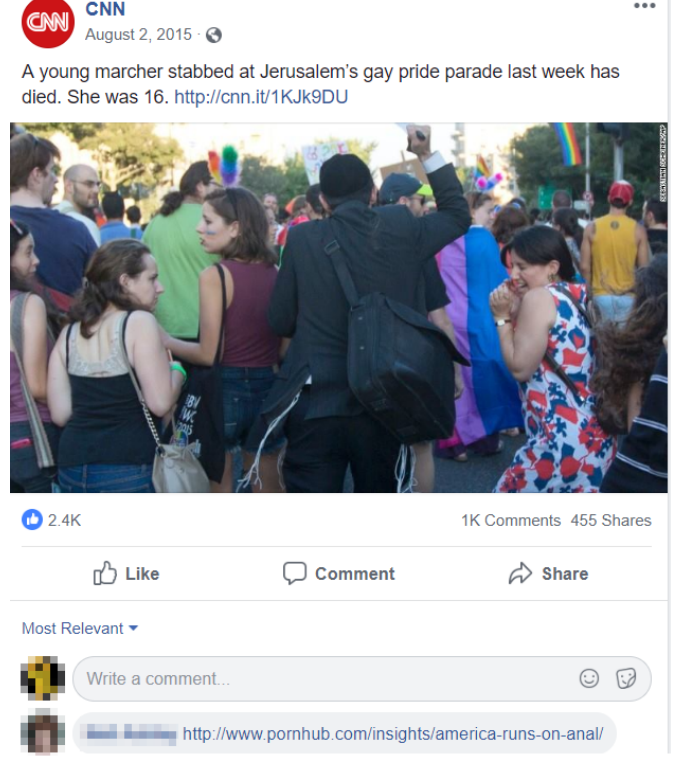
Figure 2. Pornography URL posted to comment stream of article about an LGBT pride